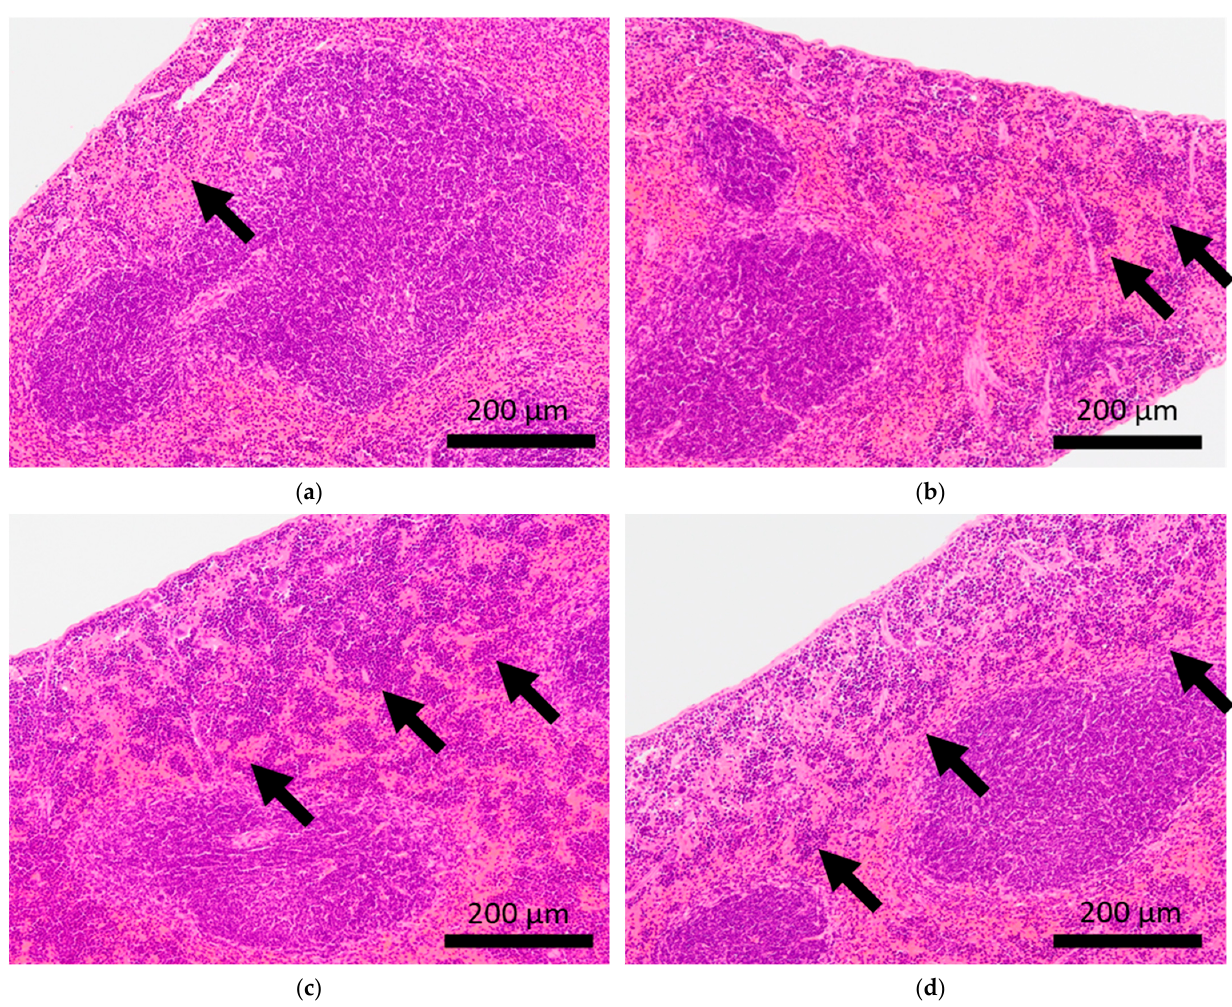
Figure 4. Histopathological features of the spleens of BALB/c mice. Arrows indicate extramedullary hematopoiesis in the spleens of control mice ( a,b ) and mice subjected to sCSDS ( c,d